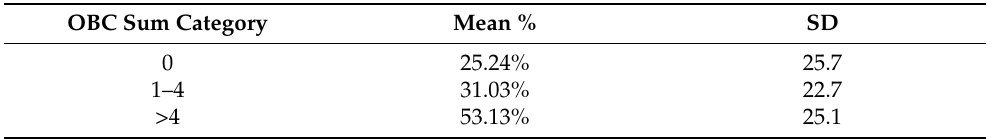
Table 6. Mean percentages and standard deviation (SD) of frequencies of “Non-Relaxed” condition recorded with the Ecological Momentary Assessment (EMA), according to the Oral Behaviours Checklist (OBC) sum